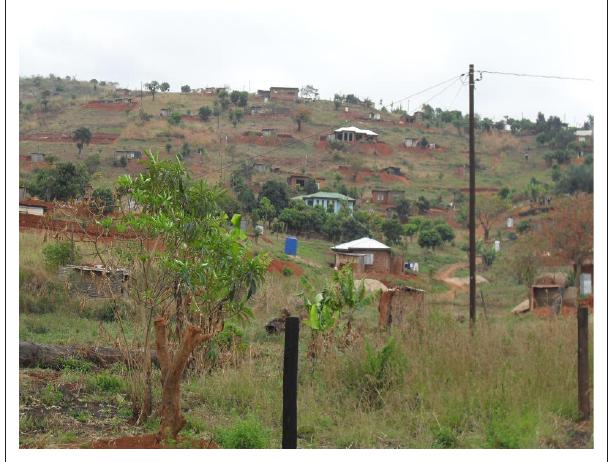
FIGURE 2: View of hill slope at